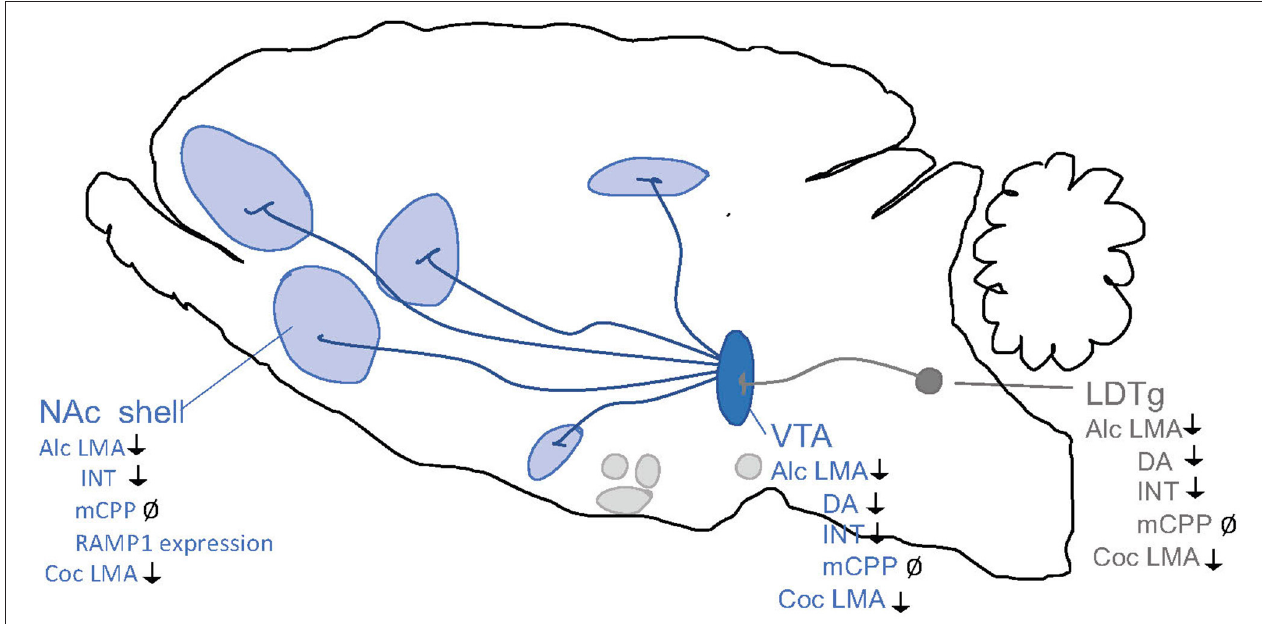
FIGURE 6 | Schematic illustrations of brain regions important for the interaction between the amylin pathway and addiction processes. Salmon calcitonin (sCT) attenuates behaviors of alcohol (Alc) and cocaine (Coc) like locomotor stimulation (LMA), conditioned place preference (CPP), dopamine release in NAc shell (DA), and alcohol intake (INT) via areas above. Ventral tegmental area (VTA), nucleus accumbens (NAc) shell, laterodorsal tegmental area (LDTg). ↓ Shows an attenuation and Ø reflects no